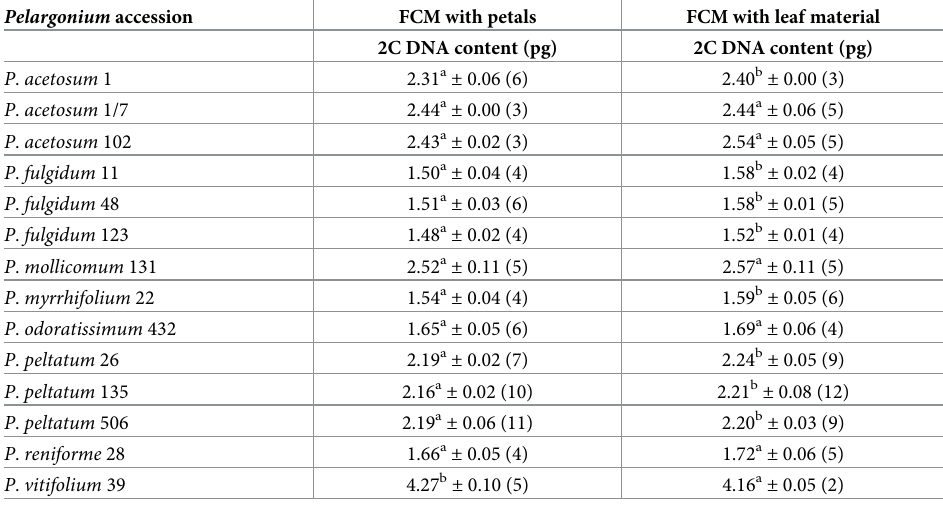
Table 2. Mean 2C DNA content (pg) of 14 Pelargonium accessions estimated with propidium iodide stained nuclei isolated from petals and leaves, respectively.